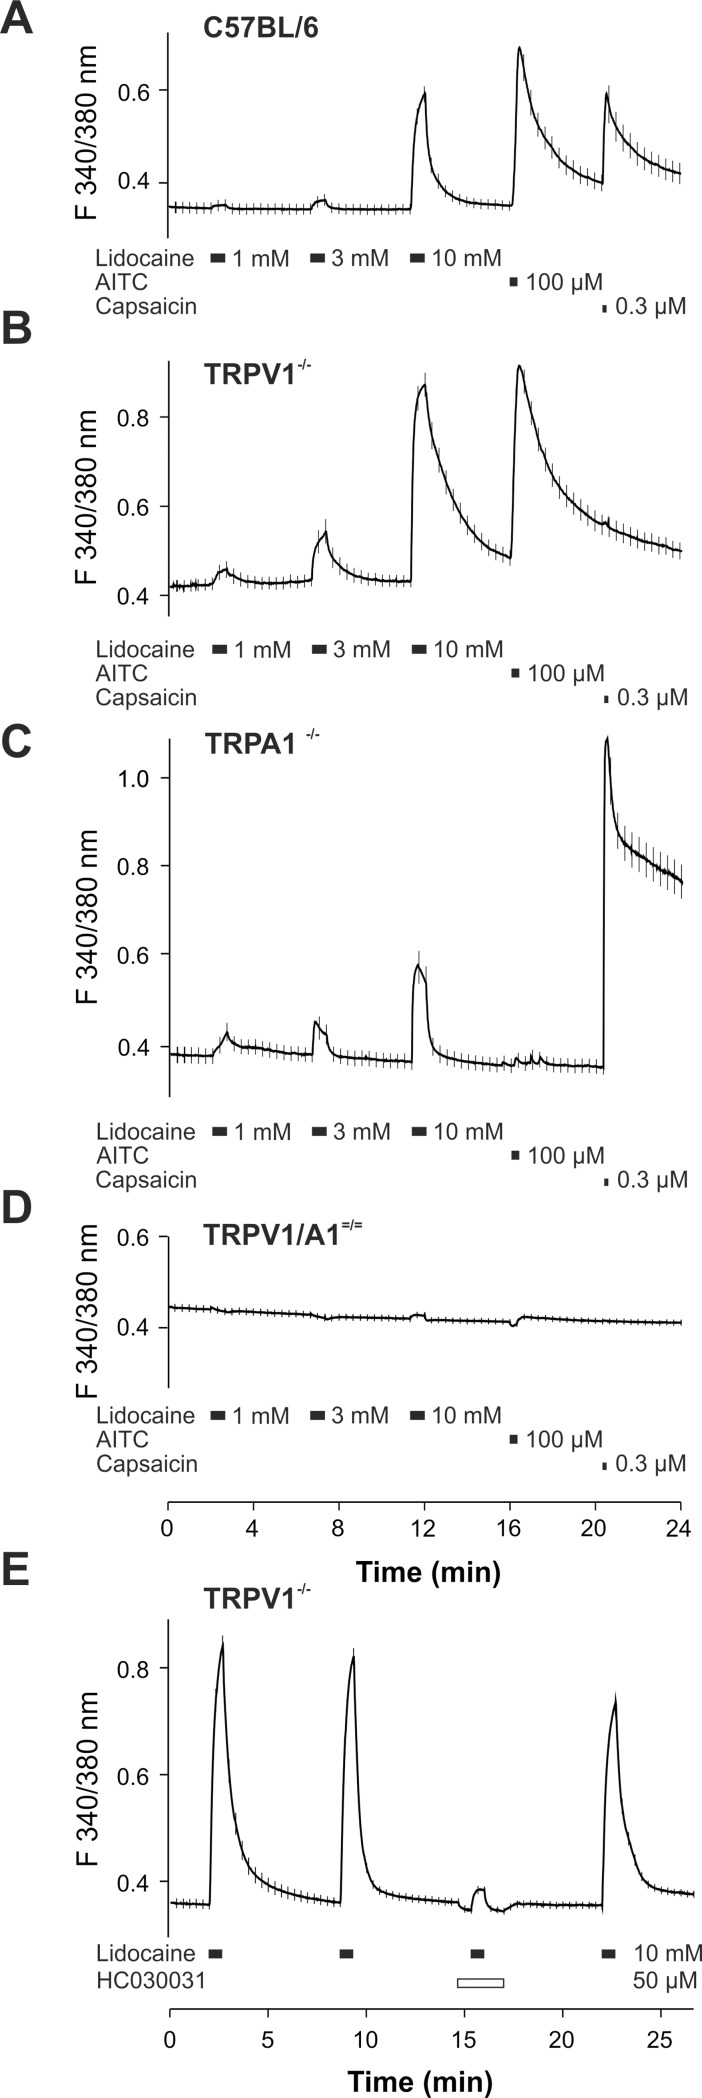
Lidocaine-induced increase in [Ca2+]i involves TRPA1 and TRPV1 receptors in DRG neurons.A- D. DRG neurons of C57Bl/6, TRPV1-/-, TRPA1-/- and TRPV1/A1-/- mice were exposed to increasing concentrations (1- 10mM) of lidocaine for 40 s (indicated by bars). Traces show averaged responses of lidocaine-responsive cells (A-E), or all measured neurons in TRPV1/A1-/- mice and are presented as mean +/- S.E.M. The S.E.M is depicted as a small vertical line along the drawn line depicting the average response (n≥ 31 for each group). E. The TRPA1 inhibitor HC030031 (50 μM) completely blocks the lidocaine-induced [Ca2+]i increase in TRPV1-/- DRG neurons (p = 0.000008, ANOVA F(3, 336) = 110.98, p = 0.0000, followed by HSD post hoc test).